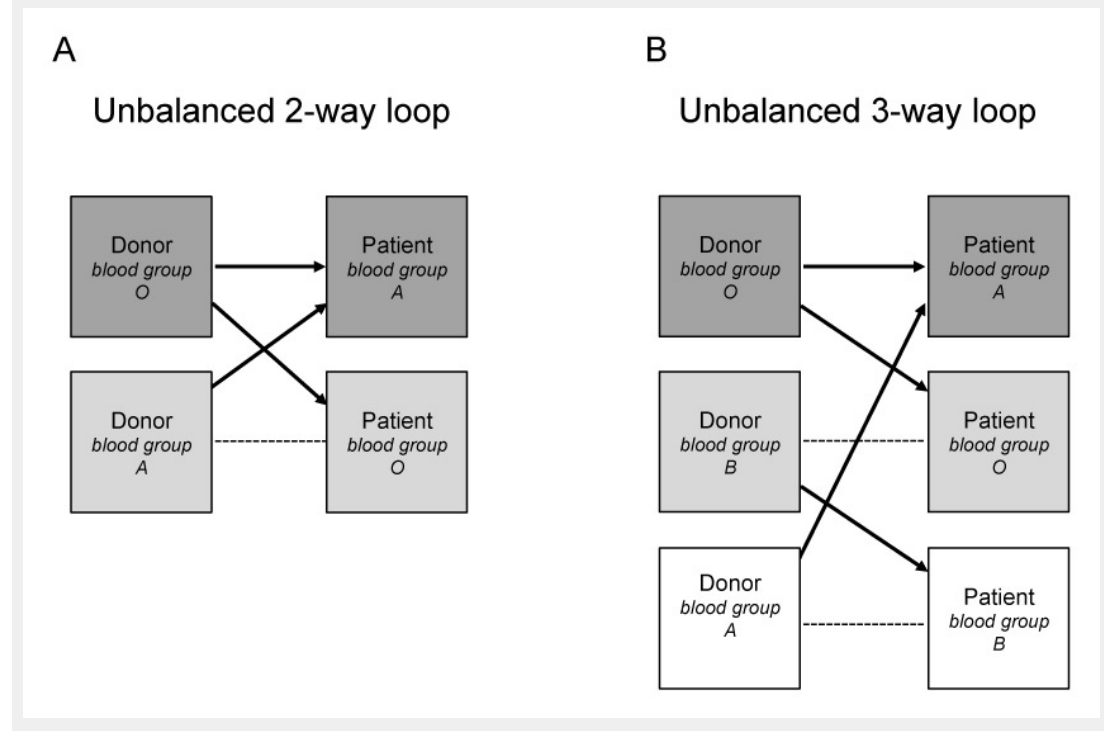
Figure 2 Exchange strategies in kidney paired donation. Unbalanced n-way loop exchanges between one compatible and one incompatible donor- recipient pairs (A) or one compatible and two incompatible donor-recipient pairs